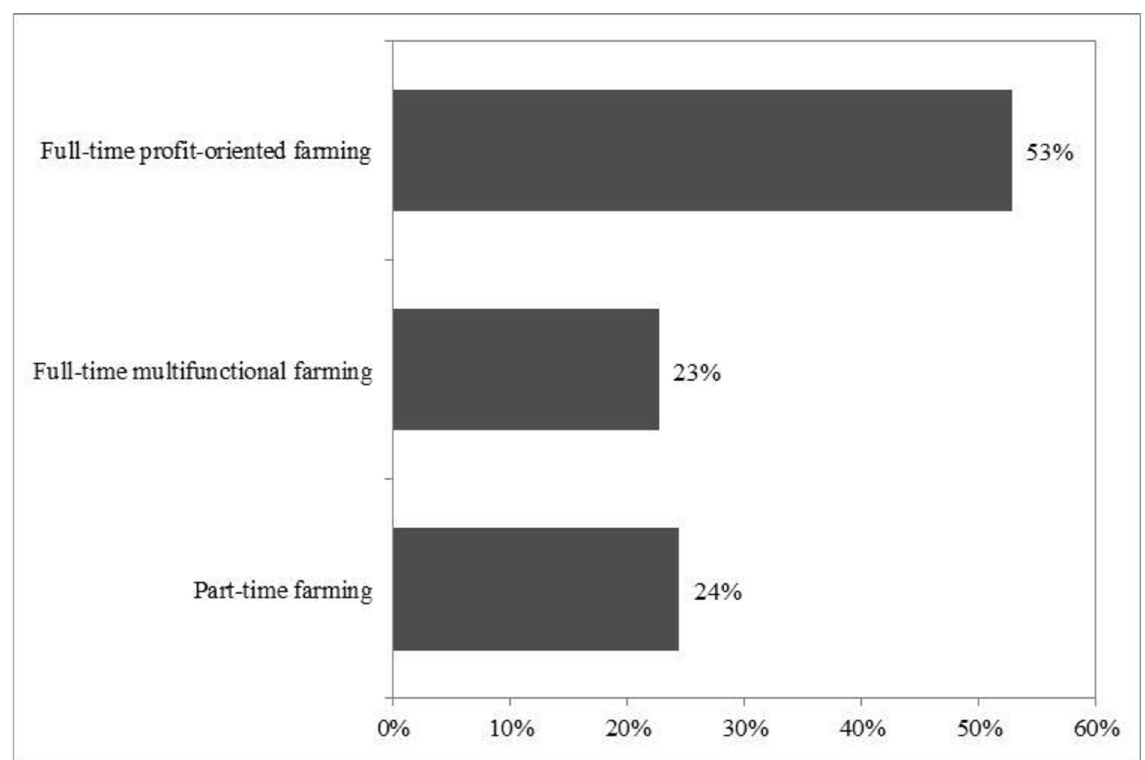
Fig 5. Types of farming (n =